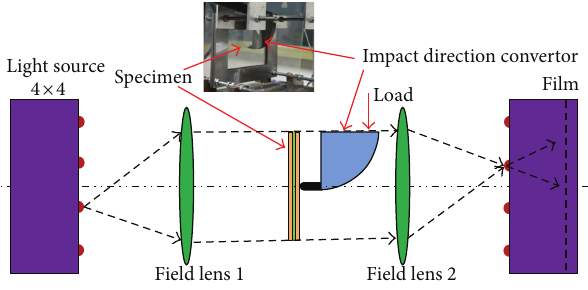
Figure 1: The schematic diagram of experimental system combing drop-weight test device with high-speed photography